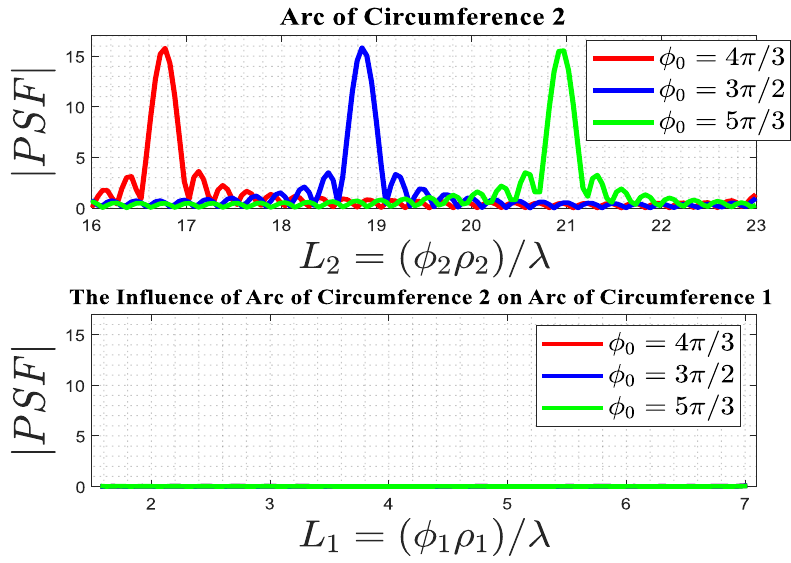
Figure 12. The influence of the PSF of the arc of circumference 2 on the other one, with ρ 1 = 3 λ and ρ 2 = 4 λ .